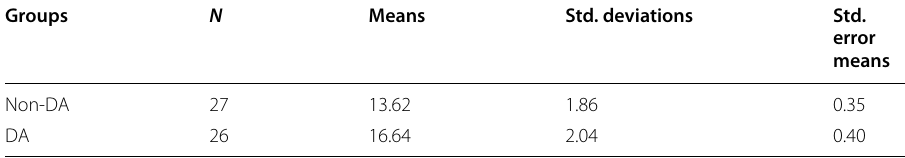
Table 3 Descriptive statistics (speaking posttest of both groups) Groups